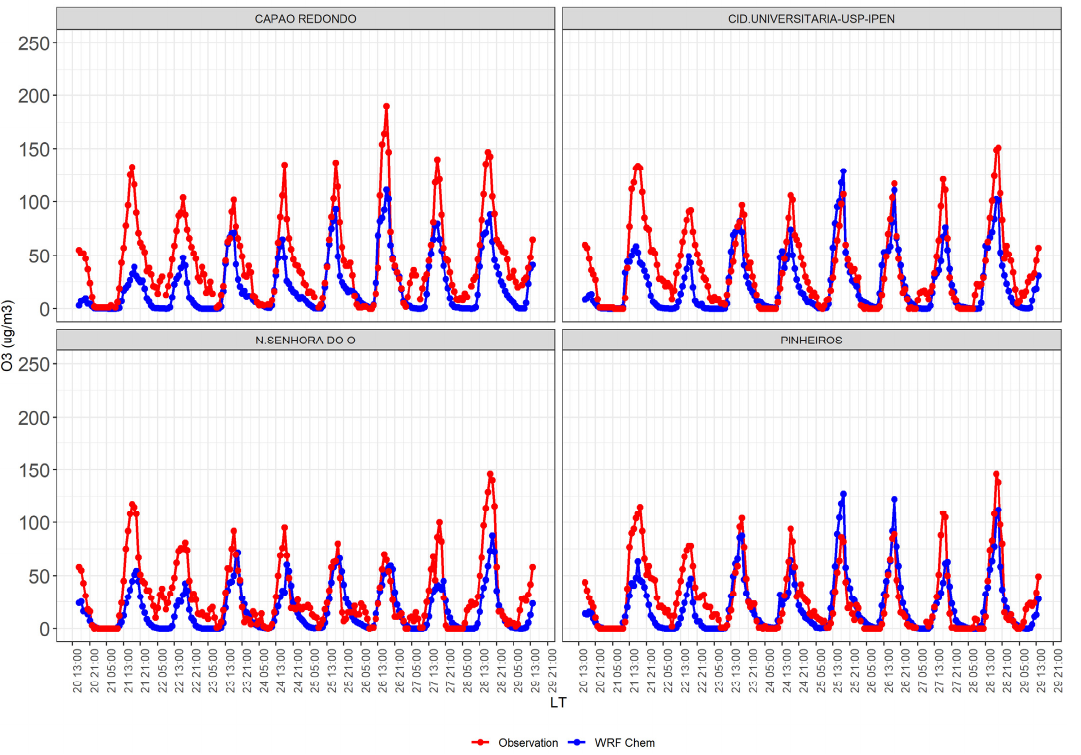
Figure 5. Concentrations of O 3 ( μ g/m 3 ) for the stations Capão Redondo, Cid. Universitaria-USP- IPEN, N.Senhora de O and Pinheiros during April 2018. Figure 6 shows the results for scenarios 0, 1, and 2 for the year 2018. The maximum hourly concentrations of the base scenario 2018 indicate that at 15:00, values of 129.14 μ g/m 3 were reached. The simulations show that the maximum ozone reductions in 2018 would be with Scenario 2 (Stage 1 + Stage 2), at 15:00, with 103.70 μ g/m 3 , representing a decrease of 25.44 μ g/m 3 . This indicates that controlling evaporative emissions in the MASP is an efficient way to reduce ozone concentrations. When we compare all the sce- narios for 2031, shown in Figure 6, it is observed that, on average, the biggest difference from Scenario 9 (L7 without ORVR, without Stage 1, and without Stage 2), which was considered as a reference scenario for the most adequate representation of the vehicle fleet that year, occurs in Scenario 6 (L7 with ORVR with Stage 1 and with Stage 2, in 2031) which reaches the value of 82.43 μ g/m 3 , followed by Scenario 5 (L7 without ORVR, with Stage 1, and Stage 2, in 2031) with 83.72 μ g/m 3 , which represents an average decrease in both scenarios of 39.92 μ g/m 3 . The comparison of the Wilcoxon test between all hourly data in Scenarios 5 and 6 shows that there are no significant differences between these two scenarios, both presenting practically the same efficiency in reducing ozone concentra- tions.